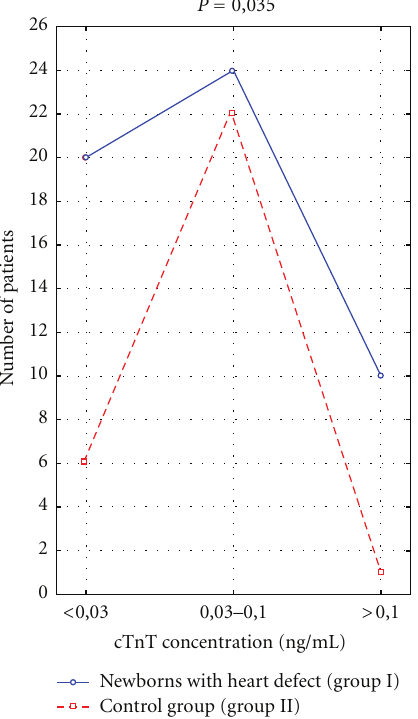
Figure 1: Number of patients with particular cTnT concentration ranges in studied